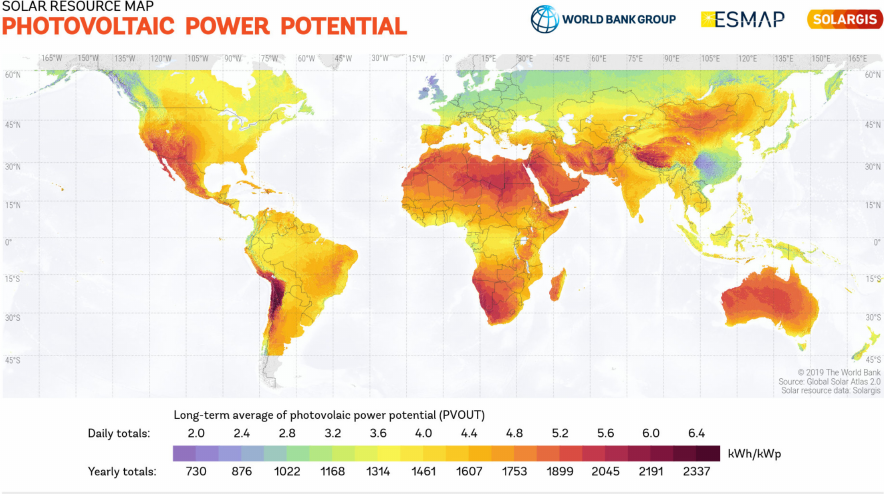
Figure 1. Global summary of estimated solar photovoltaic (PV) power generation potential [49].